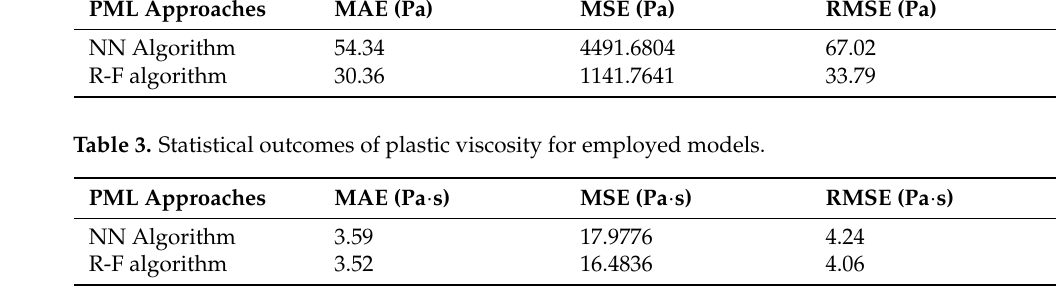
Figure 14. K-fold result of yield stress from R-F model.